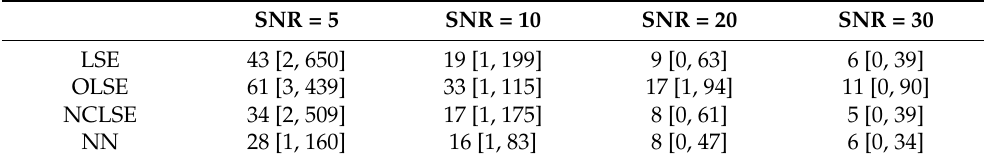
Table 2. Median absolute-valued relative quantification errors (ARQE) in the quantification of T2 relaxation times [%] as a function of fitting method and SNR. Data are given as medians [2.5th percentile, 97.5th percentile]. Please refer to Figure 1 for an explanation of the abbreviations.